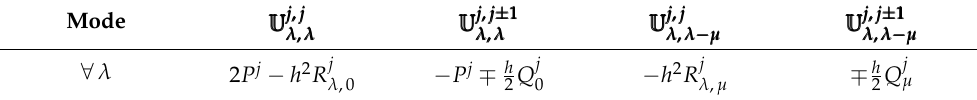
Table 2. Non-vanishing matrix elements of U for 1 ≤ j ≤ N − 1 for an annulus and a disc.